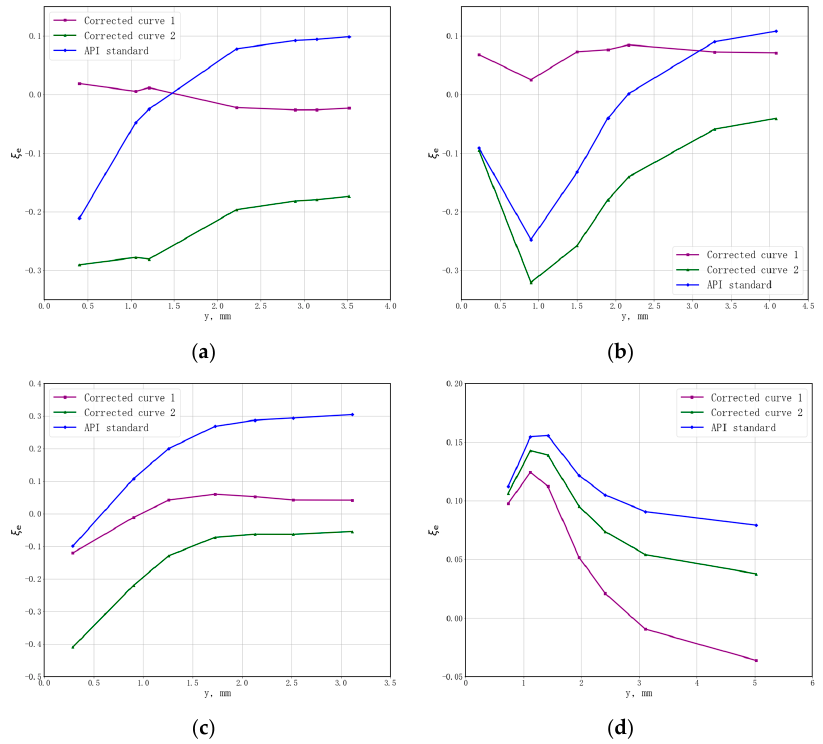
Figure 10. Error analysis of p-y curves. ( a ) Error analysis of 0% saturation. ( b ) Error analysis of 15% saturation. ( c ) Error analysis of 25% saturation. ( d ) Error analysis of 35% saturation.